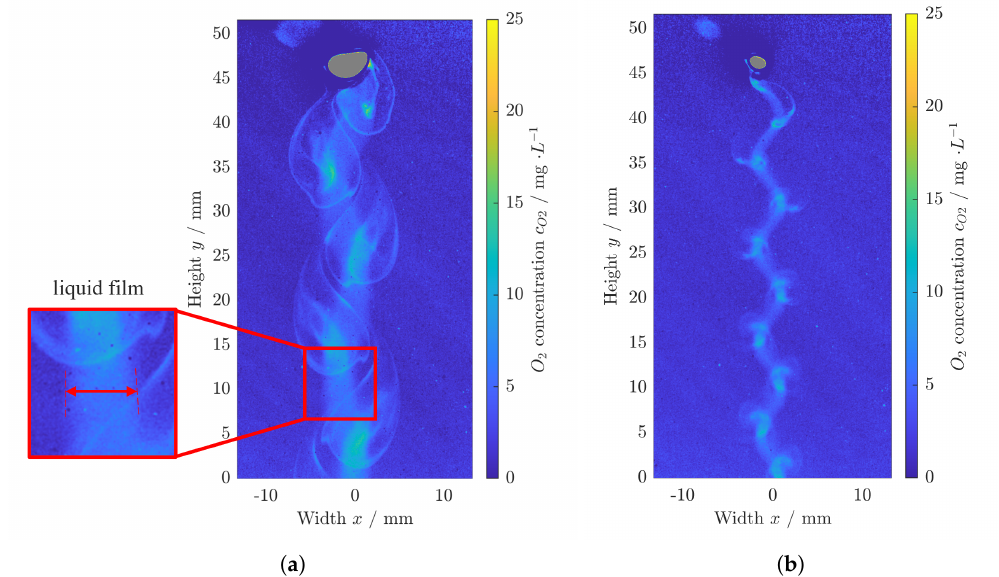
Figure 4. Evaluated concentration fields for ( a ) a wobbling bubble and ( b ) an ellipsoidal bubble. The liquid film attached to the glass wall is exemplarily highlighted in ( a ) within the red box where the arrow denotes the width of the